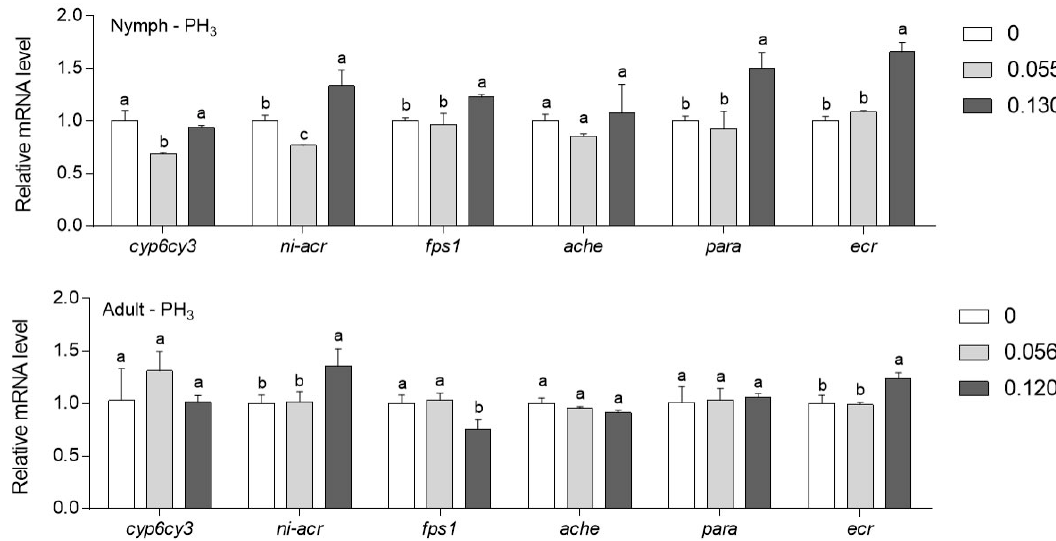
Figure 3. Gene expressions in the phosphine-treated M. persicae determined by RT-qPCR. Six gene primers are listed in Table S1. Different letters on the bars indicate statistical differences between phosphine-treated samples and the control ( p < 0.05). Statistic differences were tested using one-way ANOVA and Tukey’s test as a post-hoc test. Treated concentrations were equivalent to LC 10 (0.055 mg/L for nymphs or 0.056 mg/L for adults) and LC 50 (0.130 mg/L for nymphs or 0.120 mg/L for adults) values.